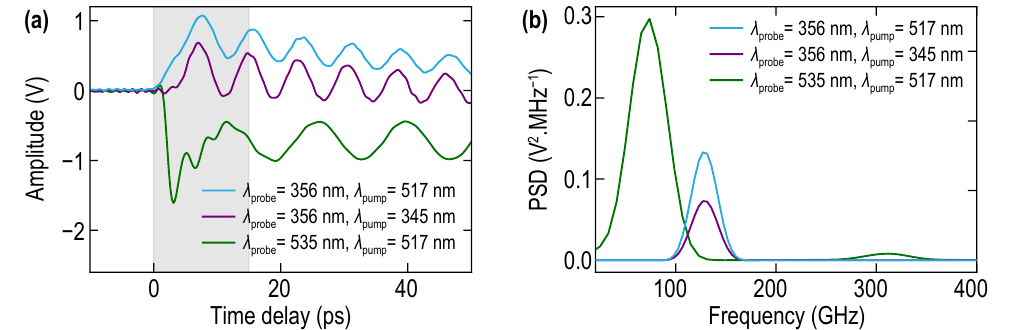
Figure 4. ( a ) Behavior of acoustic signal in the time window up to 50 ps after the sample photoexcitation for the different wavelengths of the pump and probe laser pulses and ( b ) its power spectral density (PSD) evaluated in the window from 0 to 20 ps, demonstrating the presence of a rather weak and damped vibration of the Ni layer at around 315 GHz detected by 535 nm probe light, corresponding to the half-wavelength acoustic resonance of the layer. The transient reflectivity signals and their spectra demonstrate the independence of the Brillouin oscillations frequency on the pump laser wavelength and its variations with the probe laser